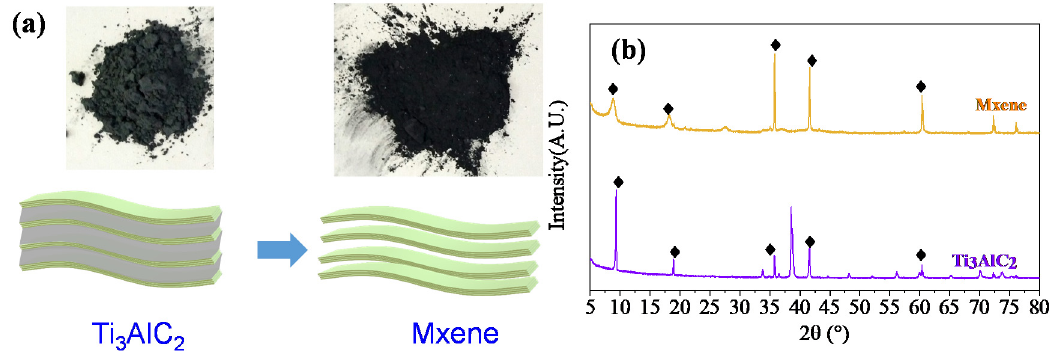
Figure 1. The preparation of Mxene by etching of Ti 3 AlC 2 : ( a ) The appearance and schematic diagram, ( b ) the comparison of XRD patterns between the Ti 3 AlC 2 and Mxene.